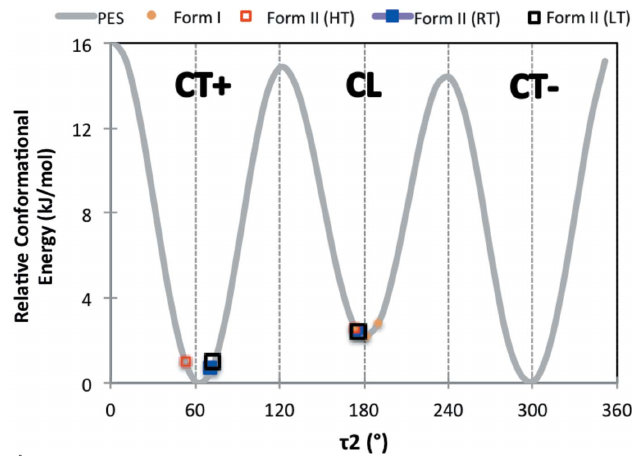
Figure 6 Conformational PES section ( (cid:3) 1 = 70 (cid:5) ) along (cid:3) 2 .